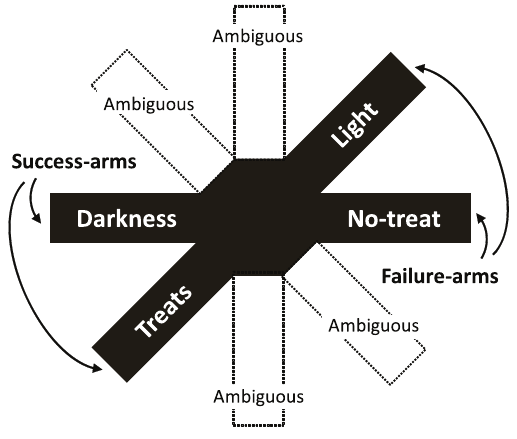
Figure 1. Overhead view of automated-maze. Rats were trained with access to the success- and failure-arms and only had access to the ambiguous-arms in the final minute of the last test.